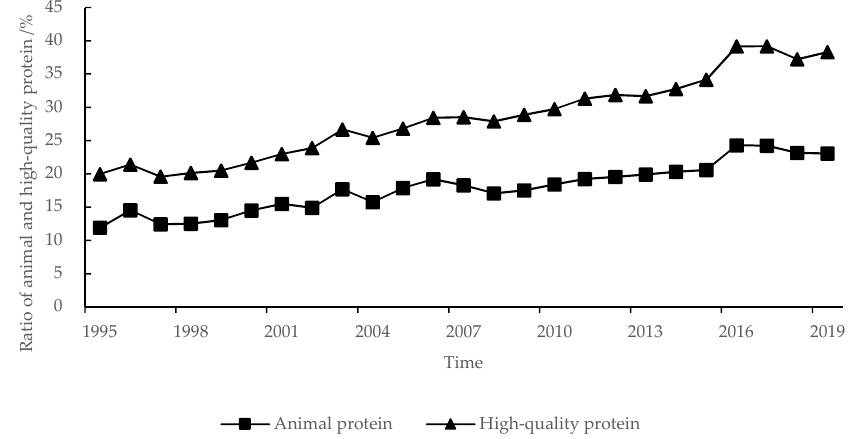
Figure 4. Ratio of animal and the high-quality protein in the QTP from 1995 to 2019.